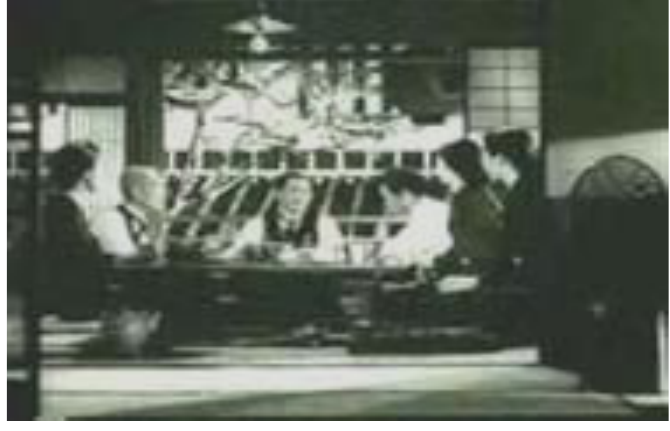
Figure 16 Tokyo Story . Director: Yasuhiro